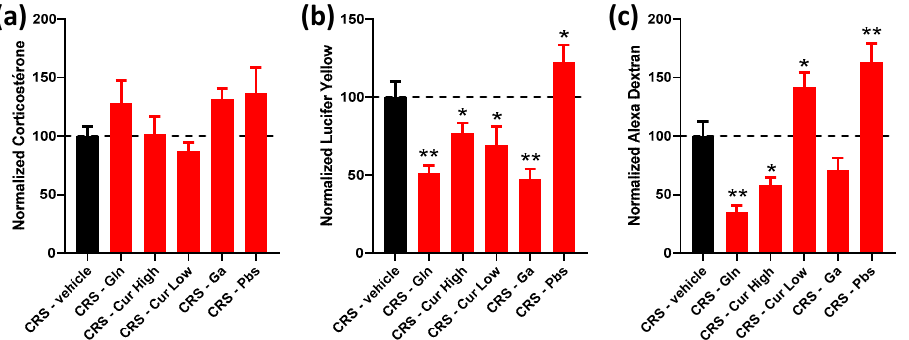
Figure 2. Effect of each selected compound administered individually on plasma corticosterone levels and colonic permeability. Normalized corticosterone levels ( a ) measured in plasma and Lucifer yellow ( b ) and Alexa Dextran ( c ) concentrations measured in Ussing chambers in CRS-vehicle (black bars) vs. CRS-Glutamine (Gln), CRS-Curcuméga ® (Cur) at high and low doses, CRS-Gabolysat ® (Ga) and CRS-Probiotics (Pbs) groups (red bars). n = 8–20 per group. Data are presented as means ± SEM. Data were compared by one-way ANOVA with Dunnett’s post hoc tests; *, p < 0.05 and **, p < 0.01 vs. CRS-vehicle. Dashed line represents the level observed in untreated CRS mice.